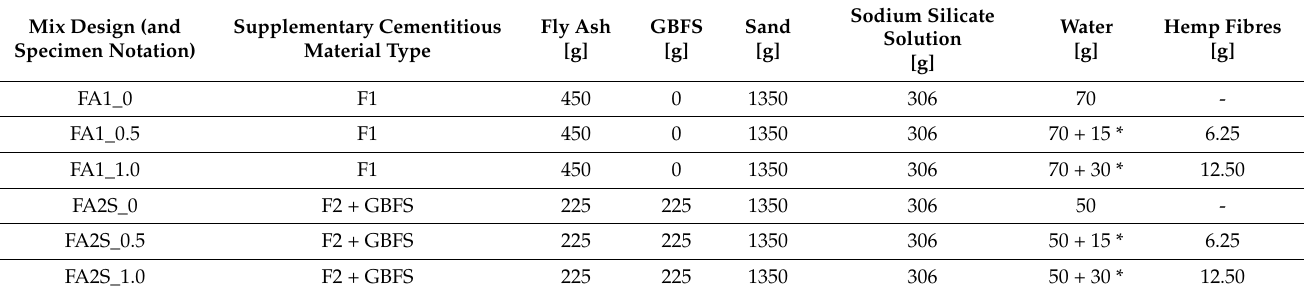
Table 2. Mortar mix design.